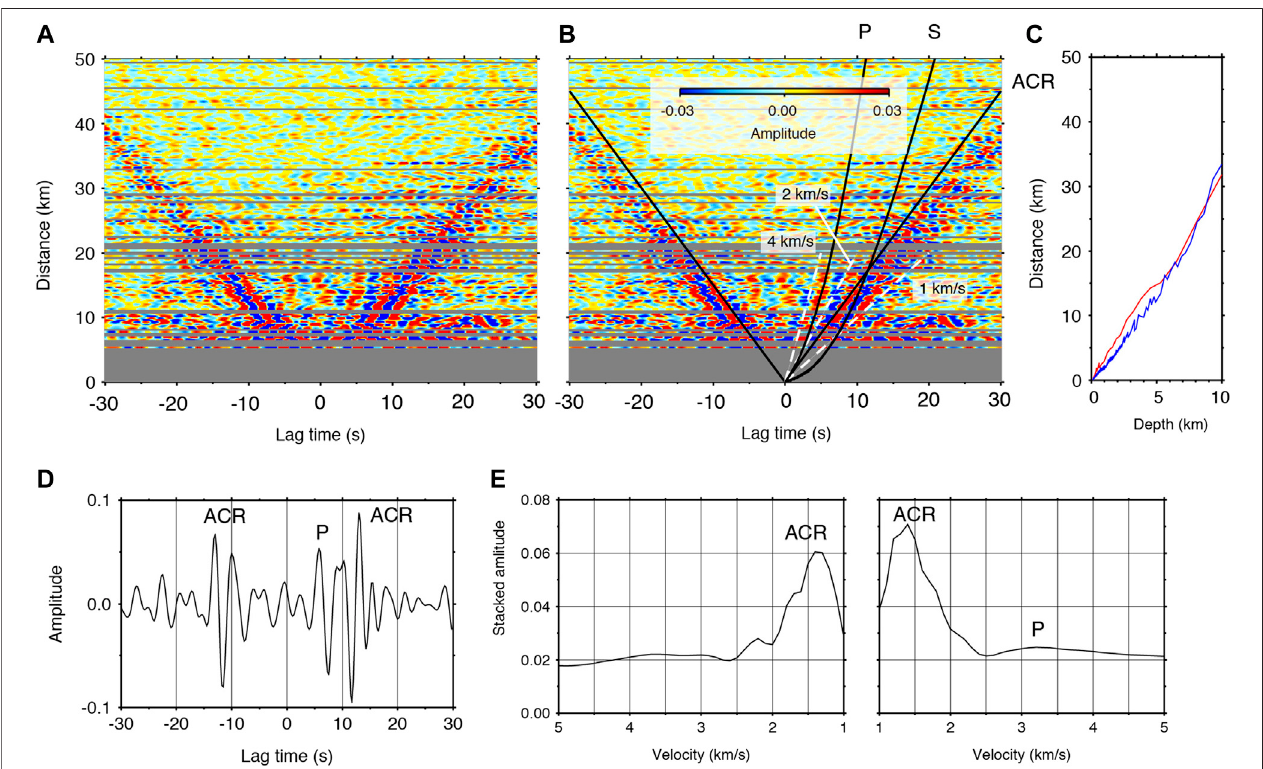
FIGURE3| CCFs aligned asafunction oftheseparation distance oftwo stations. (A) P-PCCFs at 0.2 – 0.5 Hz using DPG records. (B) Same as (A) , but with travel time curves of P and S waves calculated with a velocity model (Tonegawa et al., 2017), and a solid line with a propagation velocity of 1.5 km/s. White dashed lines representapparentvelocitiesof1,2,and4 km/s. (C) Thebottomingdepthof(red) P and(blue) S wavescalculatedusingthevelocitymodel(Tonegawaetal.,2017). (D) A stacked P-P CCF at 0.2 – 0.5 Hz for the KMB06 – KMB08 station pair, with a separation distance of 14.0 km. (E) Slant stack results for (left) negative and (right) positive lag times of the CCFs in (A)